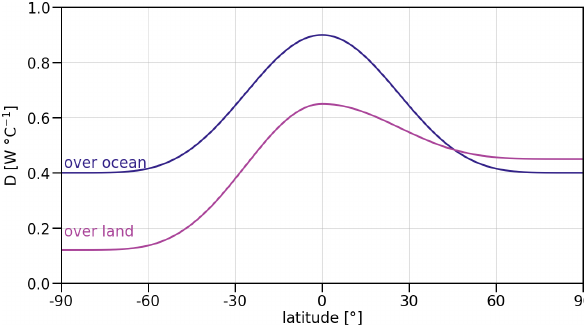
Figure 4. Effective heat transport coefficient D as modeled in TransEBM v. 1.0 and computed from the thermal conductivities κ (cf. Eq. 2). Oceanic heat transport is treated separately from that over land and ice-covered areas. For the latter, the Northern and Southern hemispheres are separated, with larger heat transport co- efficients in the